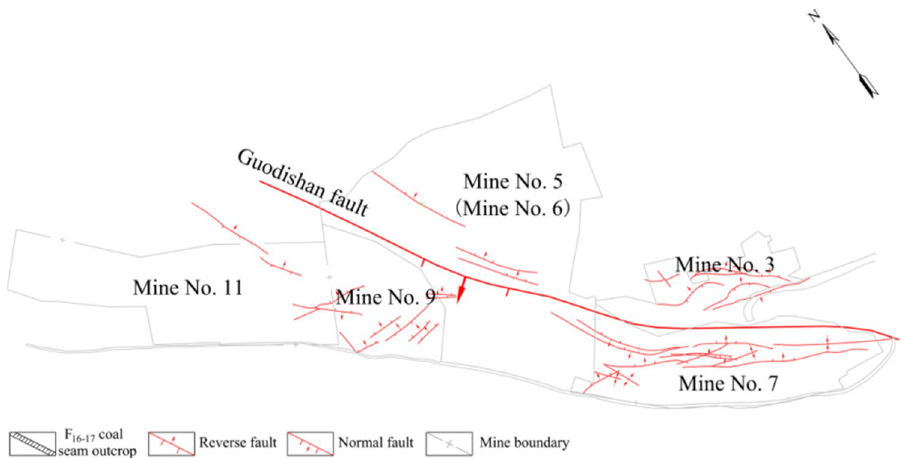
Figure 2. Schematic diagram of main structures in the west of Pingdingshan coal